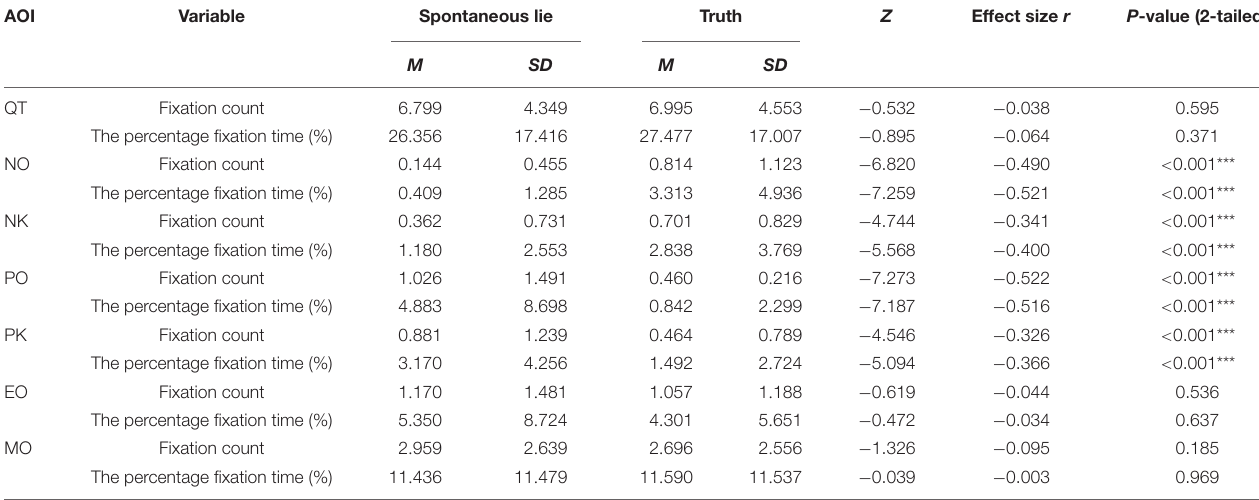
TABLE 3 | The analysis of fixation behaviors in the AOIs in Study